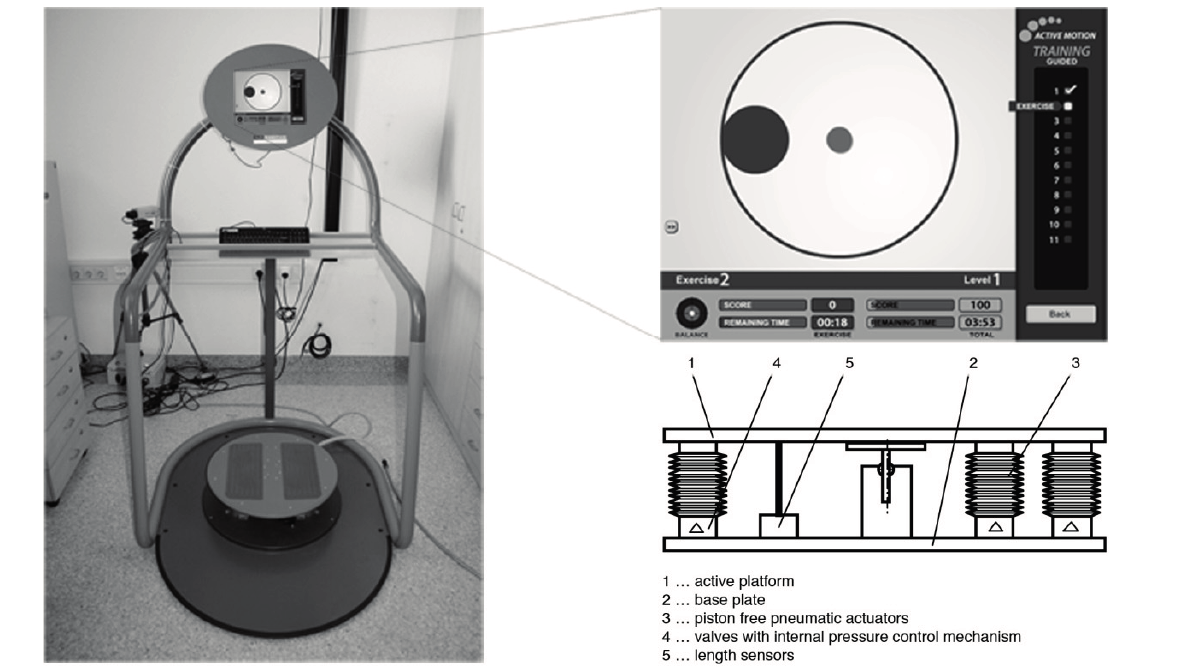
Figure 1. Test and training